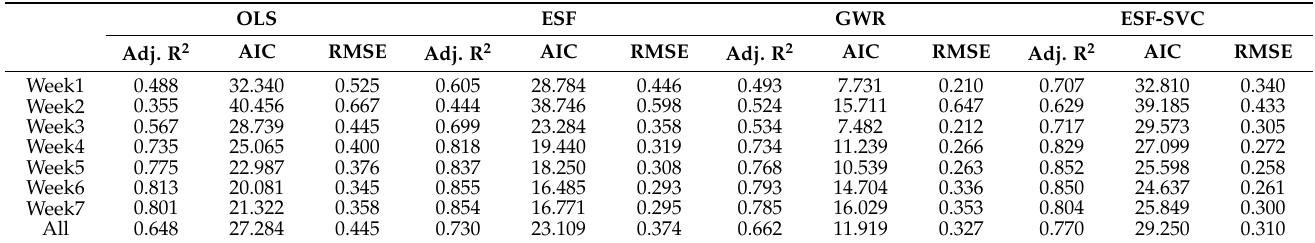
Table 4. Model performance comparison in Hubei province.